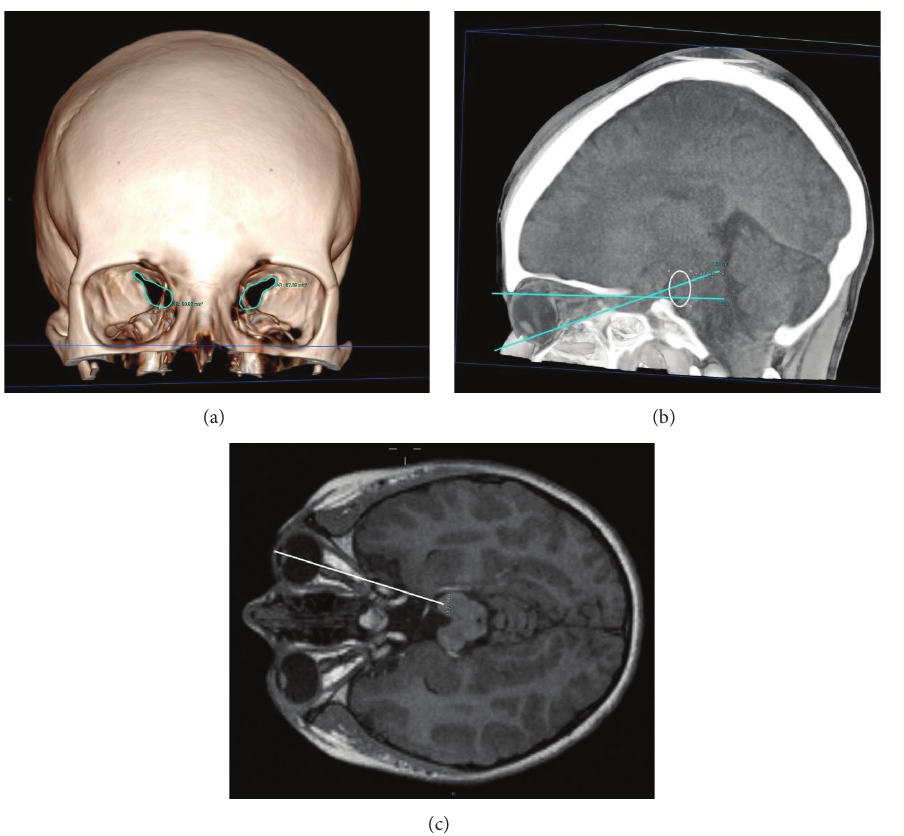
Figure 4: CT and MRI analysis of a human head to trace a possible pathway for light from the outside to the substantia nigra . (a) Human head 3D CT scan showing the large superior orbital fissure that gives access to the internal cavity of the skull. (b) Sagittal CT scan of a human head. It is evident from this prospective that the mesencephalon (indicated by the white ellipse) is behind the orbit, not hidden by the posterior clinoid process. (c) Axial MRI scan of a human head. This image shows that CSF occupies a large volume between the superior orbital fissure and the mesencephalon. Furthermore, CSF is present around the optical nerve in the intraconal space. The white line indicates the estimated distance (79.78 mm) between the cornea and the